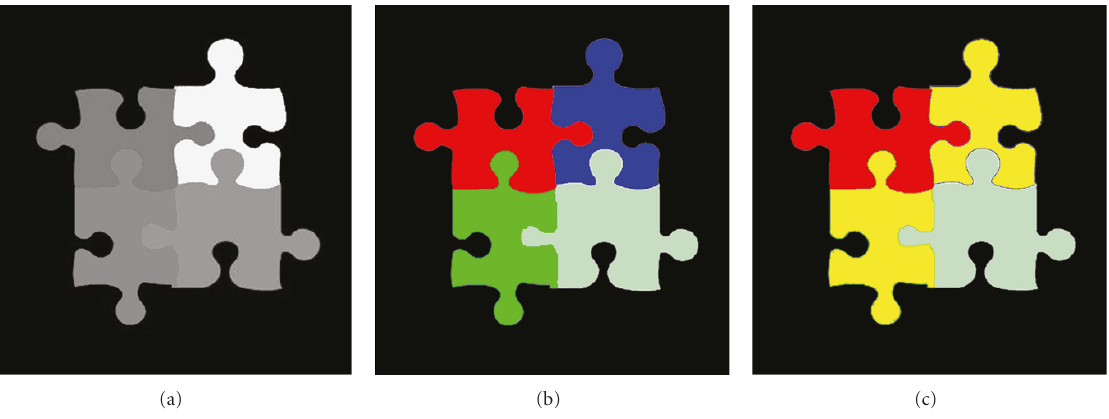
Figure 5: (a) Original image. (b) The result classified by